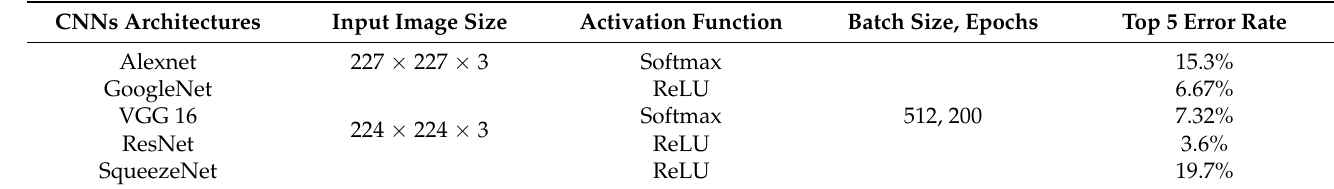
Table 4. Parameter Values of Proposed